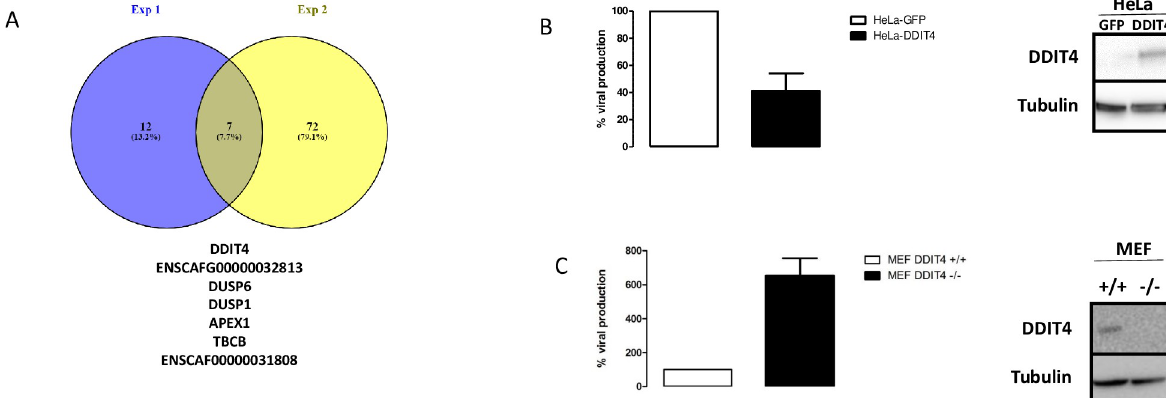
Fig 6. Analysis of the differentially expressed genes in bystander versus infected cells using the “conserved markers” strategy. A : Venn diagram of the differentially-expressed genes in bystander versus infected cells in experiments 1 and 2, using a conserved marker analysis. The 7 commonly regulated genes in the two experiments are indicated. ENSCAFG00000032813 and ENSCAF00000031808 are canine genes without human homologs. B Three days after VV infection, HeLa-GFP (white bars) or HeLa-DDIT4 (black bars) cells were collected, homogenized and the number of infectious particles generated in 30 μ L homogenate were titrated. The results are expressed as the percentage of infectious particles obtained from HeLa-GFP cells. A western blot showing the over-expression of DDIT4 in HeLa-DDIT4 compared to HeLa-GFP is presented. C : Three days after VV infection, wild-type MEF (white bars) or MEF DDIT4 -/- (black bars) were collected, homogenized and the number of infectious particles generated in 30 μ L of homogenates were titrated. The results are expressed as the percentage of infectious particles obtained from wild-type MEFs. A western blot showing the down-regulation of DDIT4 in MEF DDIT4 knock out compared to MEF wild type is presented. For B and C, the results are the mean +/- SD of three independent determinations.